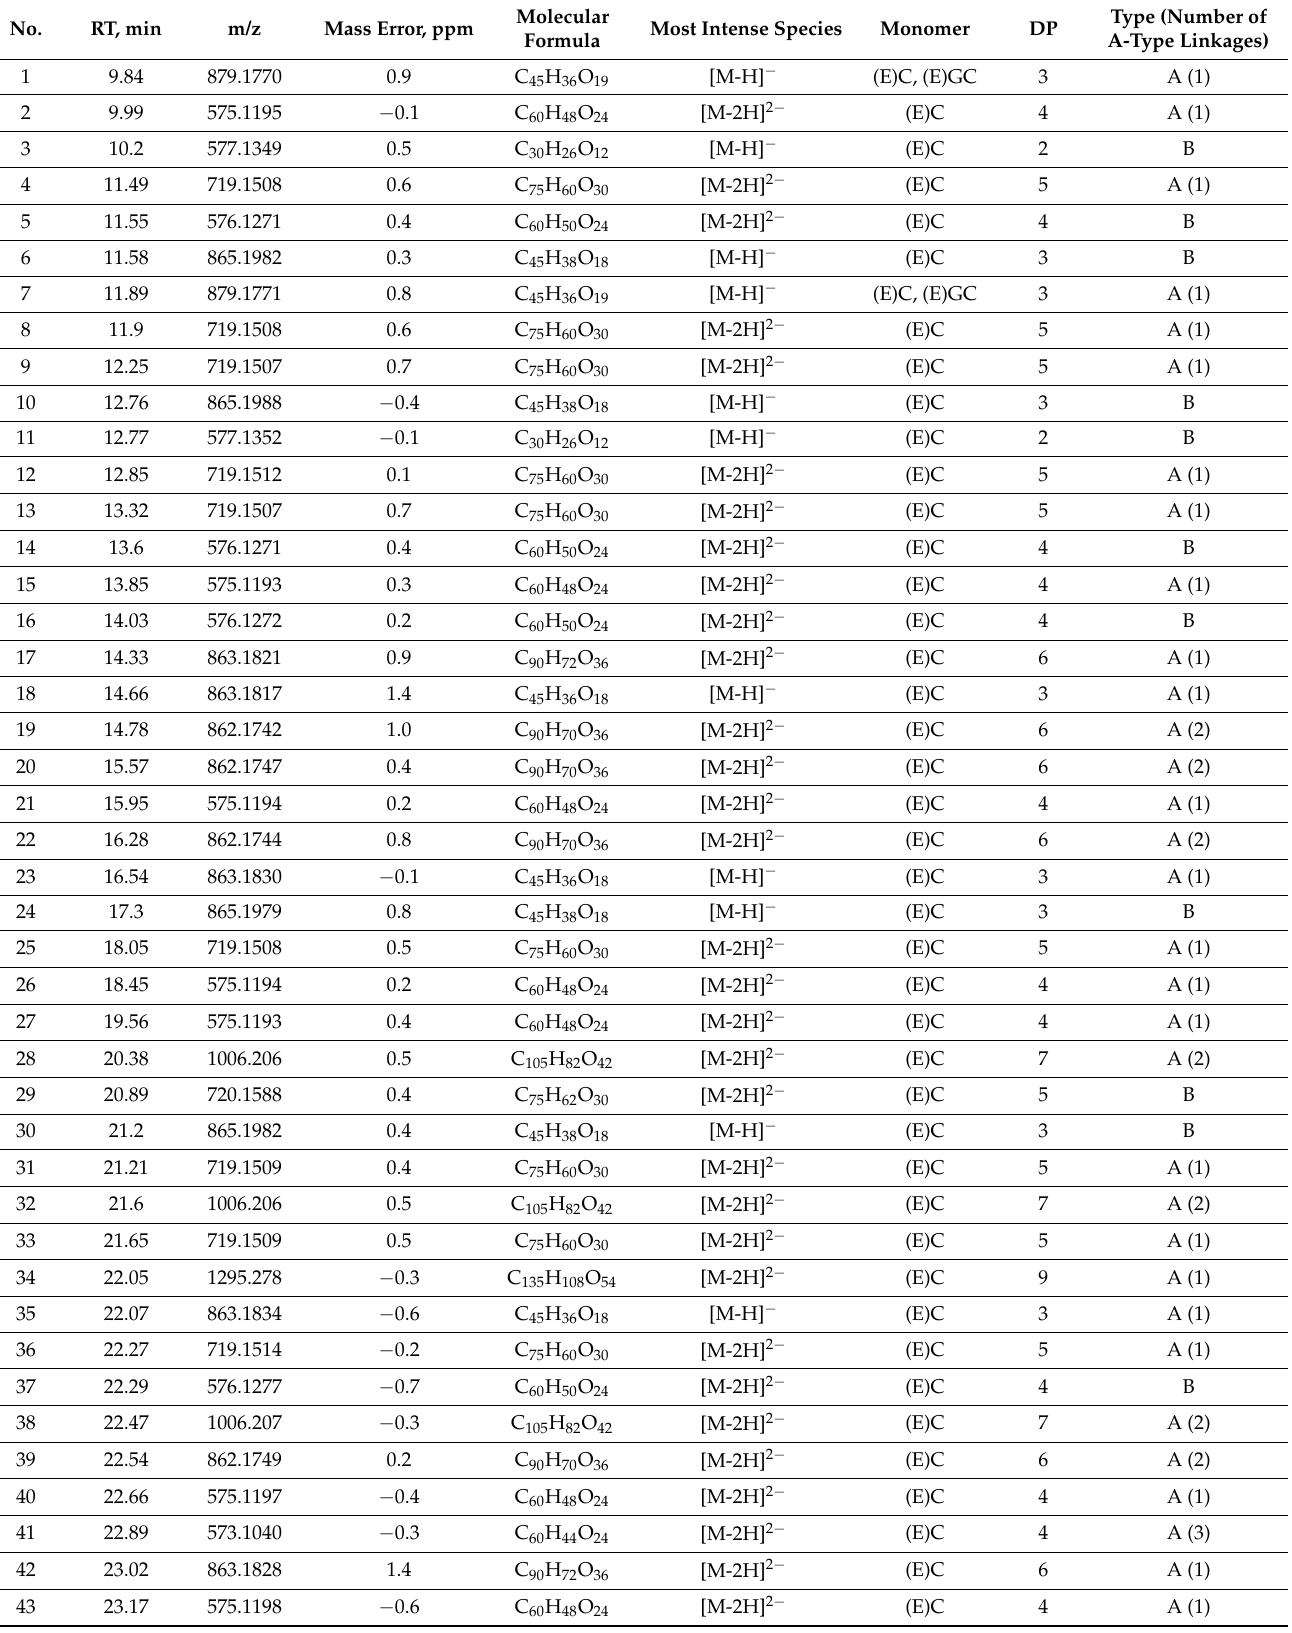
Table 4. Retention times, full-MS features and putative identities of the detected procyanidin oligomers in the purified Vaccinium macrocarpon procyanidin rich fraction. RT—retention